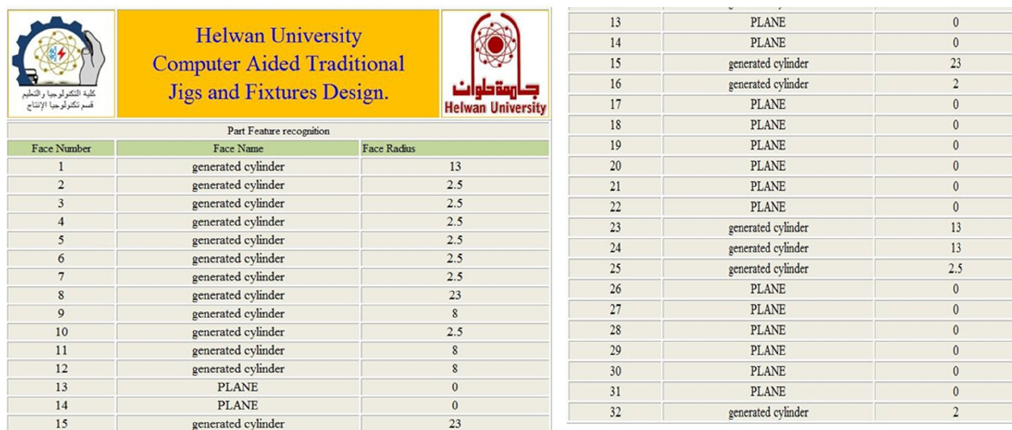
Figure 19. Report of the extracted data.